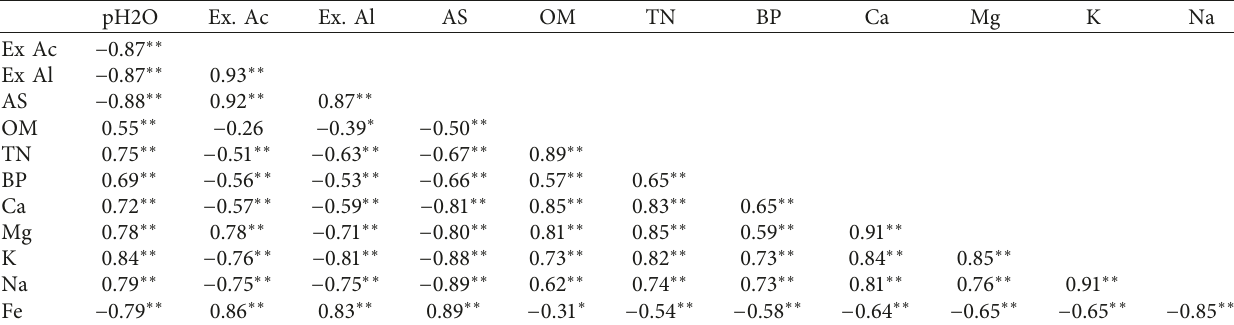
Table 4: Pearson correlation coefficients r among selected soil chemical